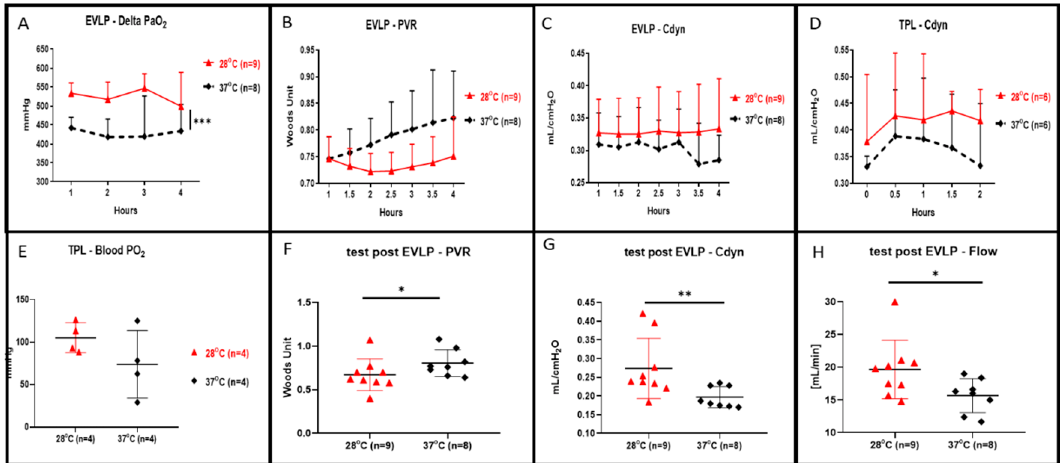
Figure 2. Lung oxygenation, pulmonary vascular resistance (PVR), dynamic compliance (Cdyn) and flow during 4 h of ex vivo lung perfusion (EVLP) and after 2 h of transplantation. ( A ) Perfusate oxygenation was significantly improved in EVLP done at 28 °C when compared to EVLP done at 37 °C temperature (*** p < 0.001). ( B ) PVR during the 28 °C EVLP was lower but not statistically different from the EVLP done at 37 °C. ( C ) Cdyn during the 28 °C EVLP was higher but were not statistically different from the EVLP done at 37 °C. ( D ) During 2 h of post EVLP transplantation reperfusion time, the compliance measured from the rat allocated to the 28 °C EVLP group was higher but not statistically different from the compliance of transplanted lungs originating from the EVLP done at 37 °C. ( E ) At the end of the 2 h post-transplantation reperfusion, the oxygenation from the pulmonary vein was higher in the lungs allocated from the 28 °C EVLP group but was not statistically different when compared to the control group. ( F ) In the 28 °C EVLP group and during the 5 min end of EVLP stress test we recorded a significant lower PVR (* p < 0.05) and ( G ) a significantly higher Cdyn (* p < 0.05, ** p < 0.01) and ( H ) a significantly higher flow (* p < 0.05) when compared to the normothermic group.